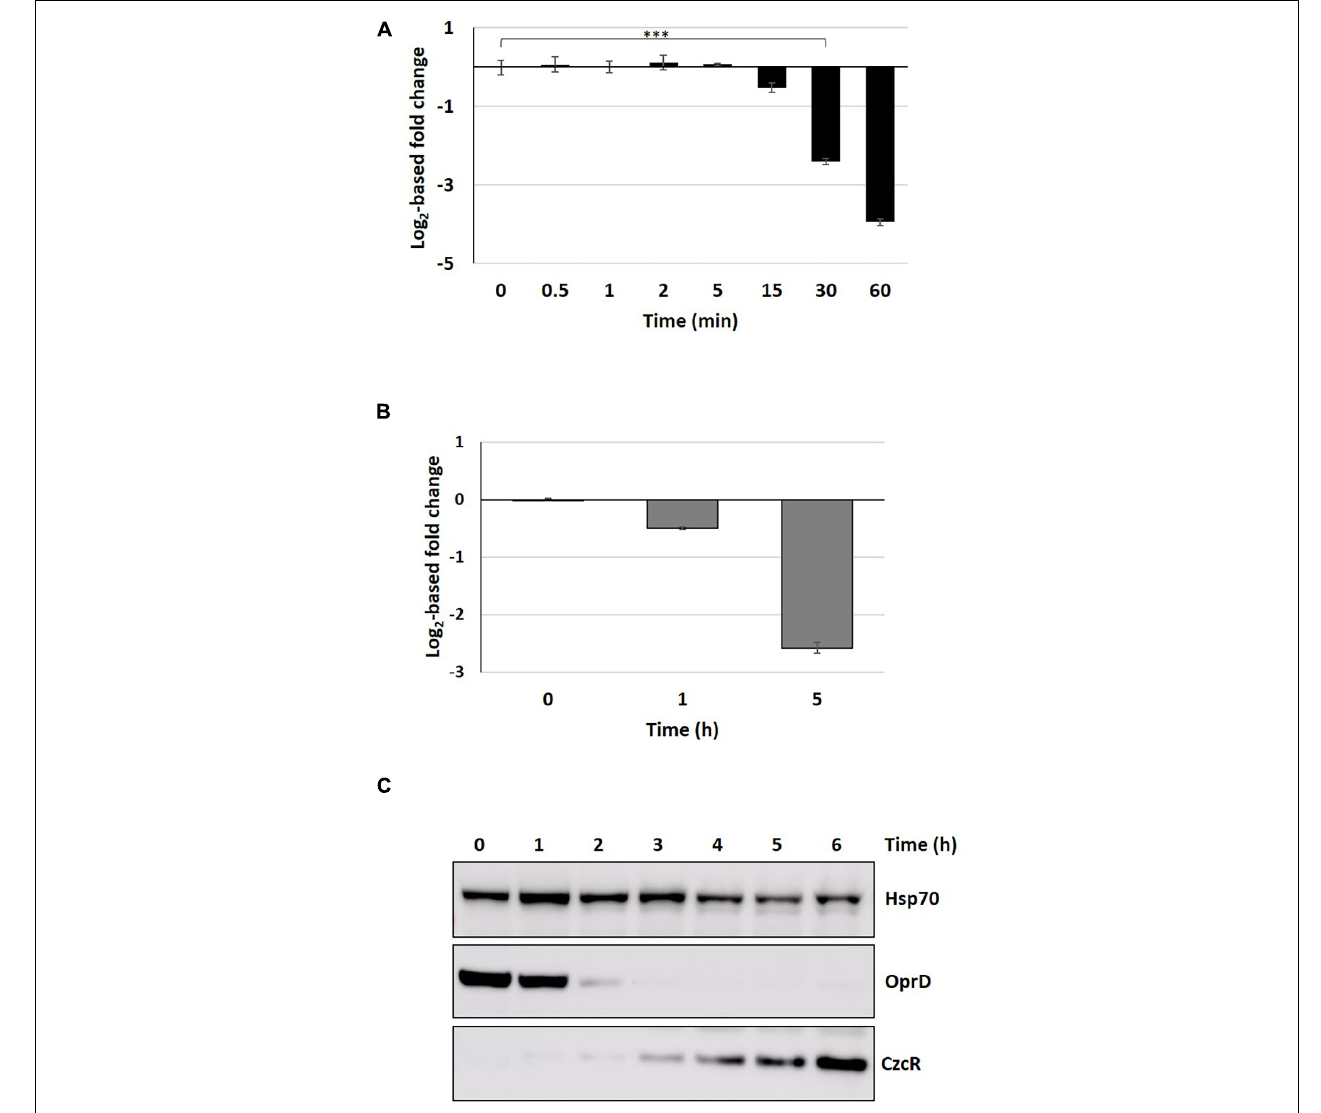
FIGURE 7 | Proteomic and transcriptomic kinetics of OprD repression. (A) Fold change in oprD mRNA obtained by the NanoString technique after addition of 2 mM ZnCl 2 . Mean values of fold change compared to t0 (before addition of Zn) and standard deviations (error bars) of three independent experiments are represented. Statistical analyses were performed according to the Student’s t -test and p -values are given as follows: ≤ 0.001 (***). (B) Fold change in OprD porin compared to t0 (before addition of Zn), 1 and 5 h after addition of 2 mM Zn. (C) Western blot analysis of total protein sampled without Zn (t0) and after 1–6 h following the addition of 2 mM ZnCl 2 . Blots were decorated with anti-OprD, anti-CzcR, and anti-Hsp70 as loading